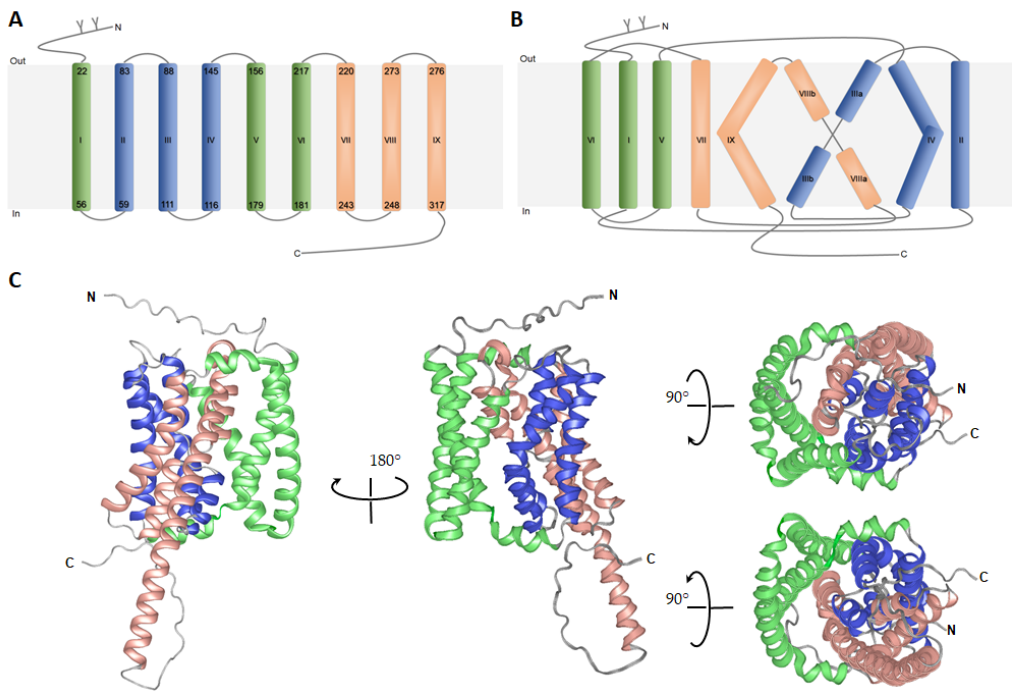
Figure 2. Three-dimensional model of human NTCP predicted using AlphaFold. ( A ) Schematic representation of nine transmembrane domains (TMDs I-IX) of human NTCP with indicated aa positions of the α -helices (Arabic numbers). Transmembrane domains are marked (Greek letters) and colored: I, IV and V (green, panel domain); II, III, IV (blue, core domain); and VII, VIII and IX (orange, core domain). N-terminal glycosylation of the N5 and N11 are demonstrated as “Y”. ( B ) Proposed membrane topology of human NTCP based on AlphaFold prediction (AF-Q14973-F1-model_v1). ( C ) Backbone structure of human NTCP protein, where α -helices are represented by coiled ribbons, and protein loops are shown as thin lines. Positions of N- and C-termini are labeled. Two identical structures are related by a 90-degree rotation. The model was visualized by the Protean 3D DNASTAR Software.